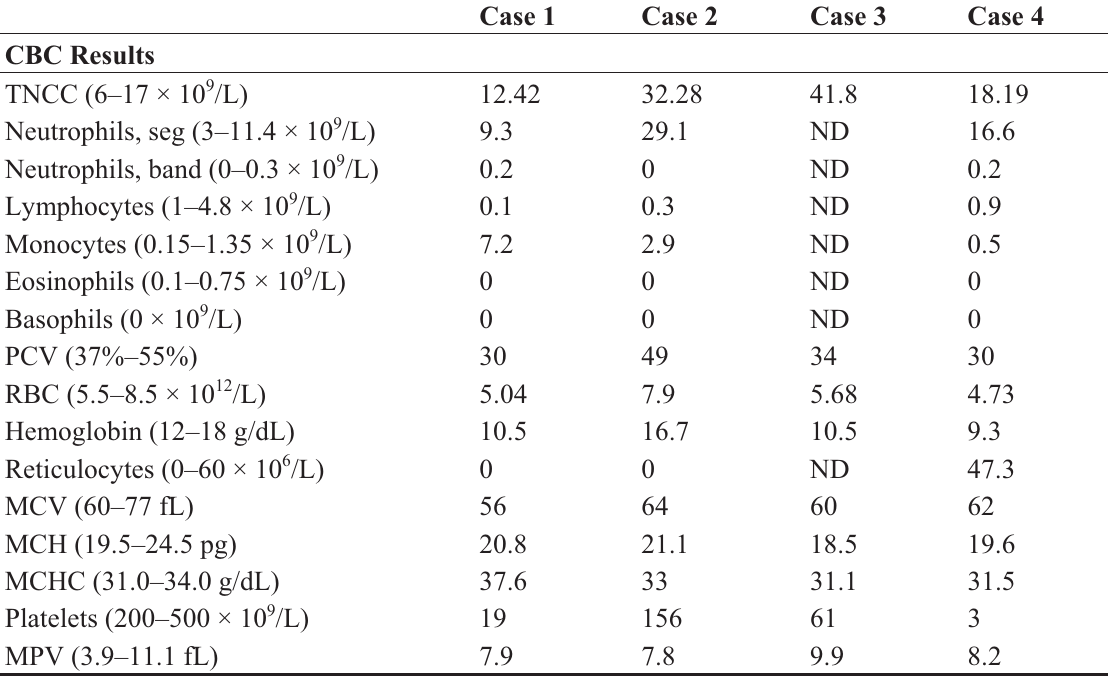
Table 1. Results of complete blood count (CBC), serum biochemistry testing, and